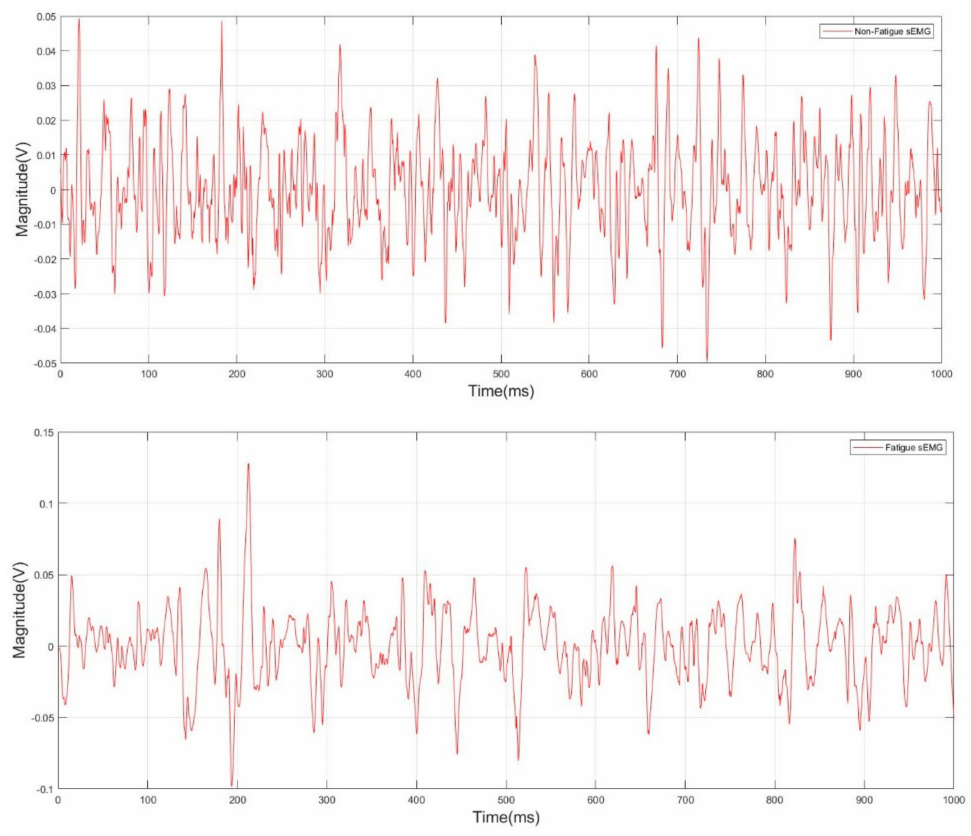
Figure 5. Non-fatigue and fatigue filtered sEMG